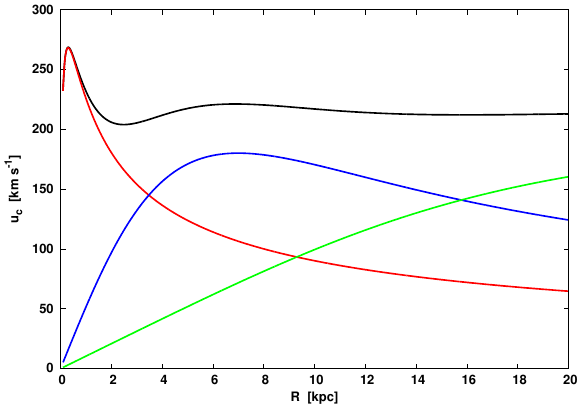
Fig. 1. Rotation curve of the Milky Way (black) with the curves due to the components: bulge (red), M kpc, disc (blue) M